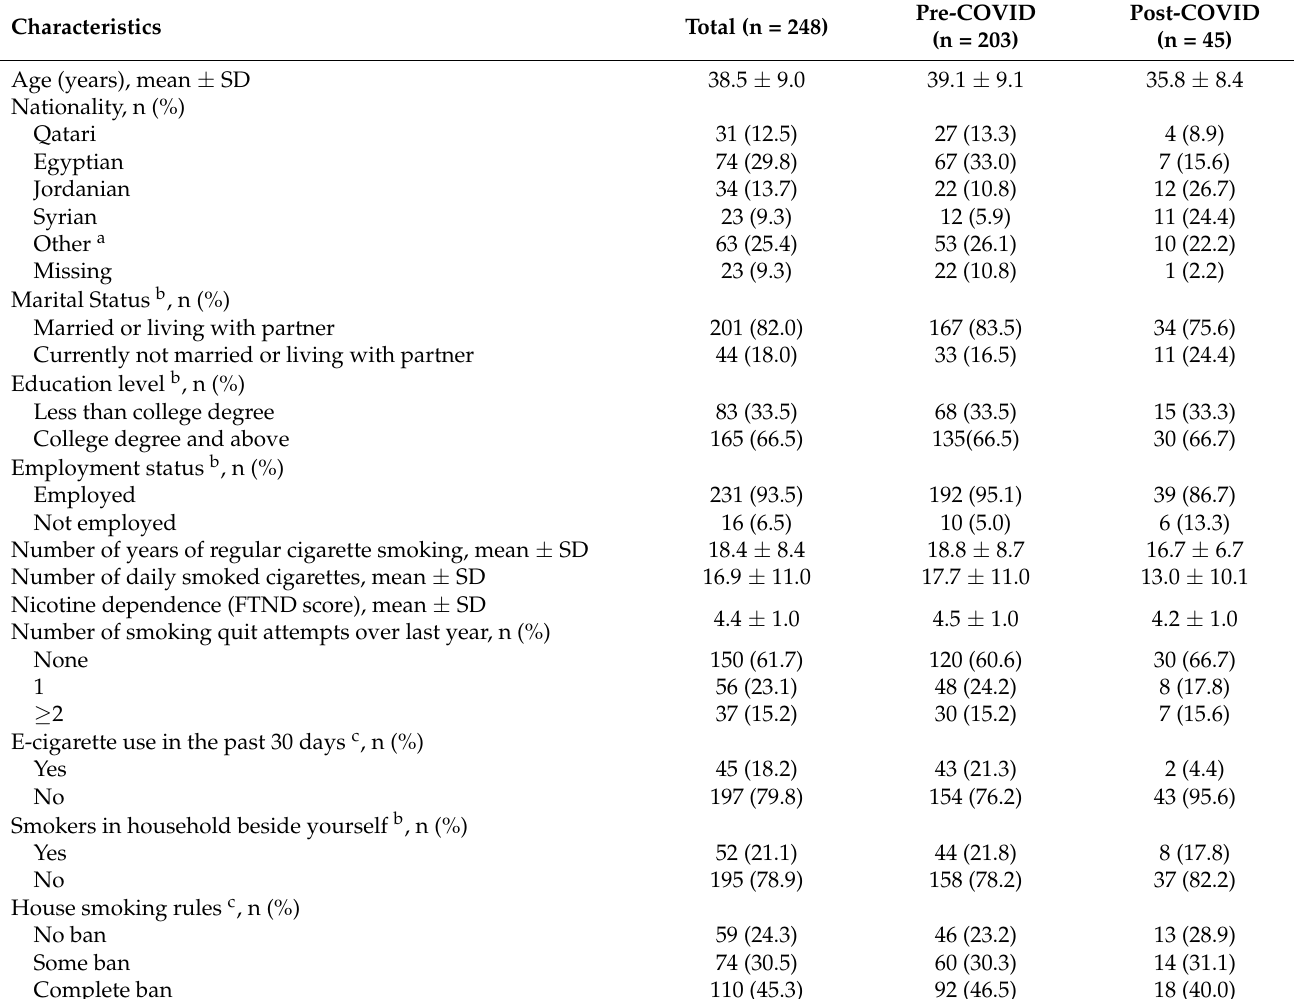
Table 1. Baseline characteristics of participants, overall (n = 248) and pre- (n = 203) and post-COVID (n = 45)